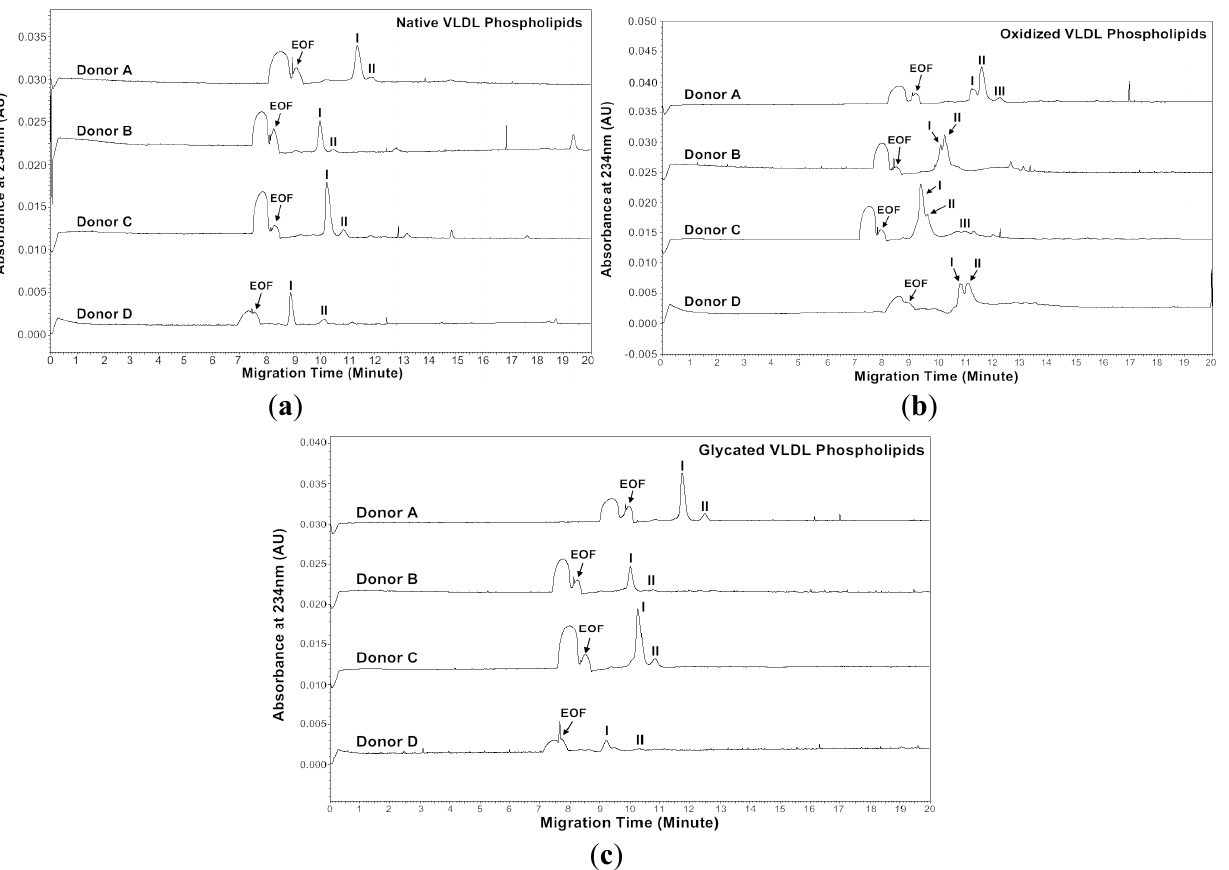
Figure 6. MEKC profiles of ( a ) native, ( b ) in vitro oxidized and ( c ) in vitro glycated VLDL phospholipids of four healthy subjects measured at absorbance 234 nm. MEKC conditions are the same as Figure